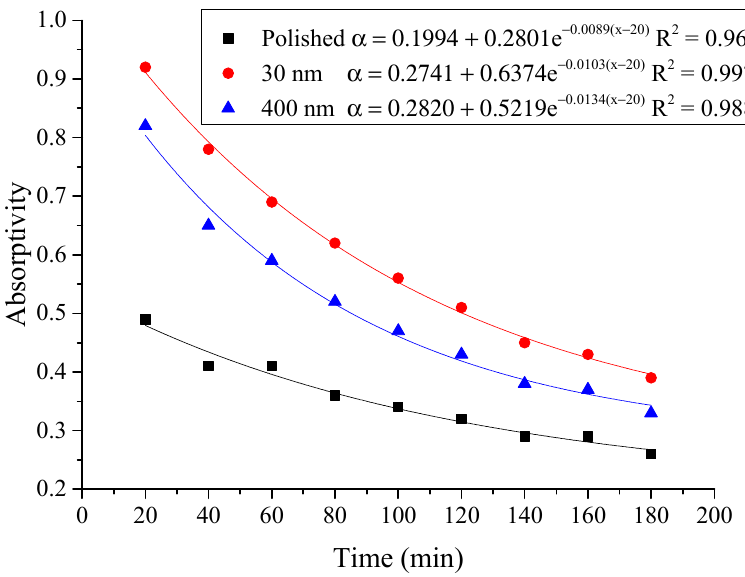
Figure 14. Variation of the average absorptivity for the testing rigs operated under the simulated radiation of 100 W/m 2 .